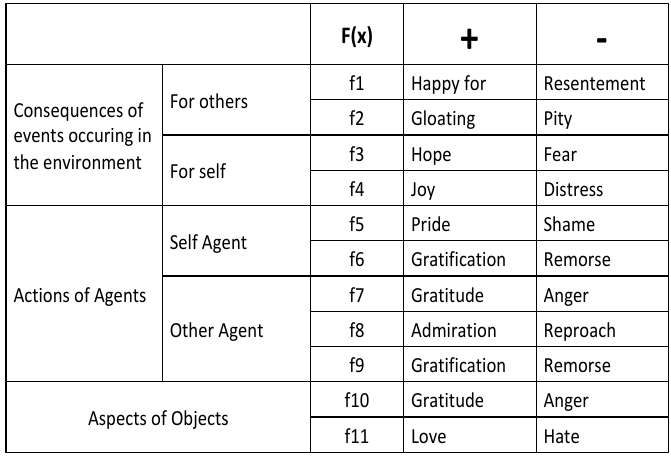
Figure 10. Parameters of the Ortony Clore Collins (OCC) model and functions